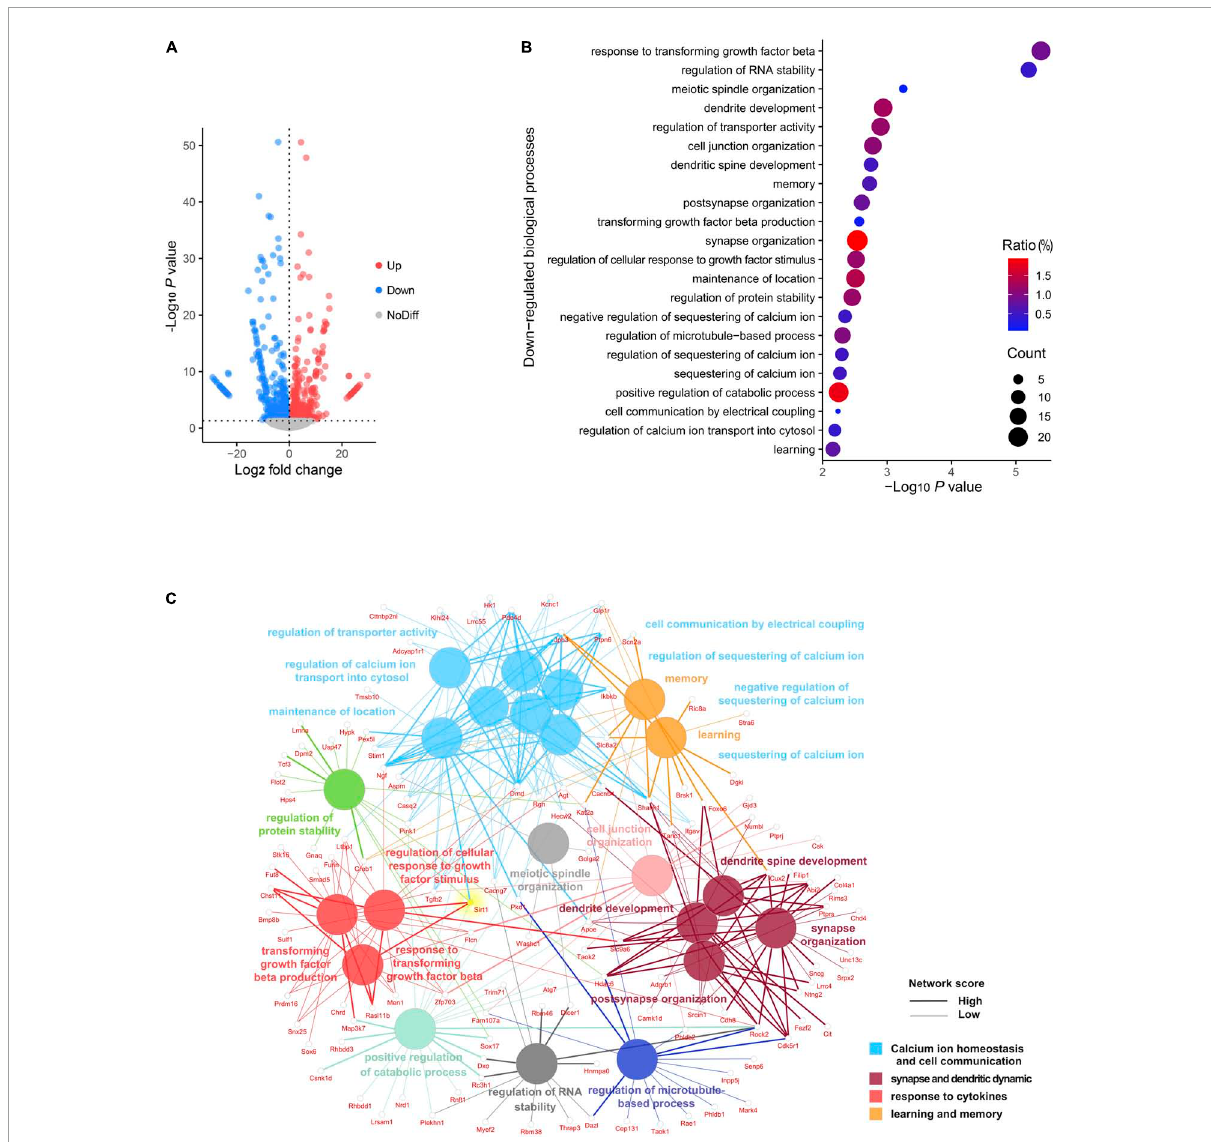
FIGURE2 Panorama of RNA changes when compared postoperative cognitive dysfunction (POCD) to control group. (A) Volcano plot representation of differentially expressed gene distribution ( p < 0.05). (B) Dot plot of top 22 Gene Ontology (GO) terms for downregulated biological processes. (C) Network analysis of top 22 downregulated biological processes among the gene interaction networks.